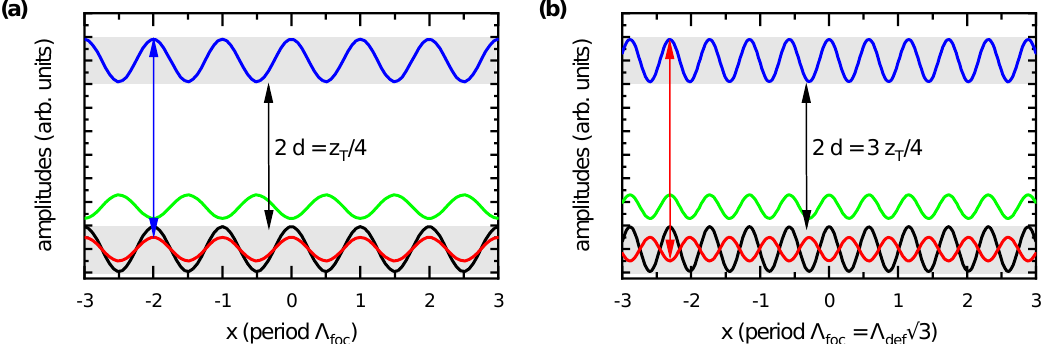
Figure 2. Illustration of feedback loop for single-mirror feedback. The x -axis shows transverse space in periods of the pattern. The y -axis denotes amplitude, but via the vertical displacements also propagation distance. The two light grey regions represent the atomic cloud as encountered by the forward beam (bottom) and the backwards beam reentering the cloud (top) after propagating to the mirror and back (distance 2 d , indicated by black arrow). The thick black line indicates a modulation of an atomic state variable, here for concreteness the population ρ ee of the excited state. The red line shows the resulting modulation of the refractive index. The green line indicates the phase of the transmitted beam just after traversing the cloud. The blue line indicates the amplitude modulation created in the backward beam by diffractive dephasing. ( a ) Blue detuning: After a quarter of the Talbot distance intensity maxima in the backward beam are aligned with refractive index maxima (blue arrow) providing positive feedback for a self-focusing nonlinearity. ( b ) Red detuning: After a three quarters of the Talbot distance intensity maxima in the backward beam are aligned with refractive index minima (red arrow) providing positive feedback for a self-defocusing nonlinearity. Hence, the period of the spatial modulation √ in the cloud experiencing maximum positive feedback for a given mirror distance d is reduced by a factor